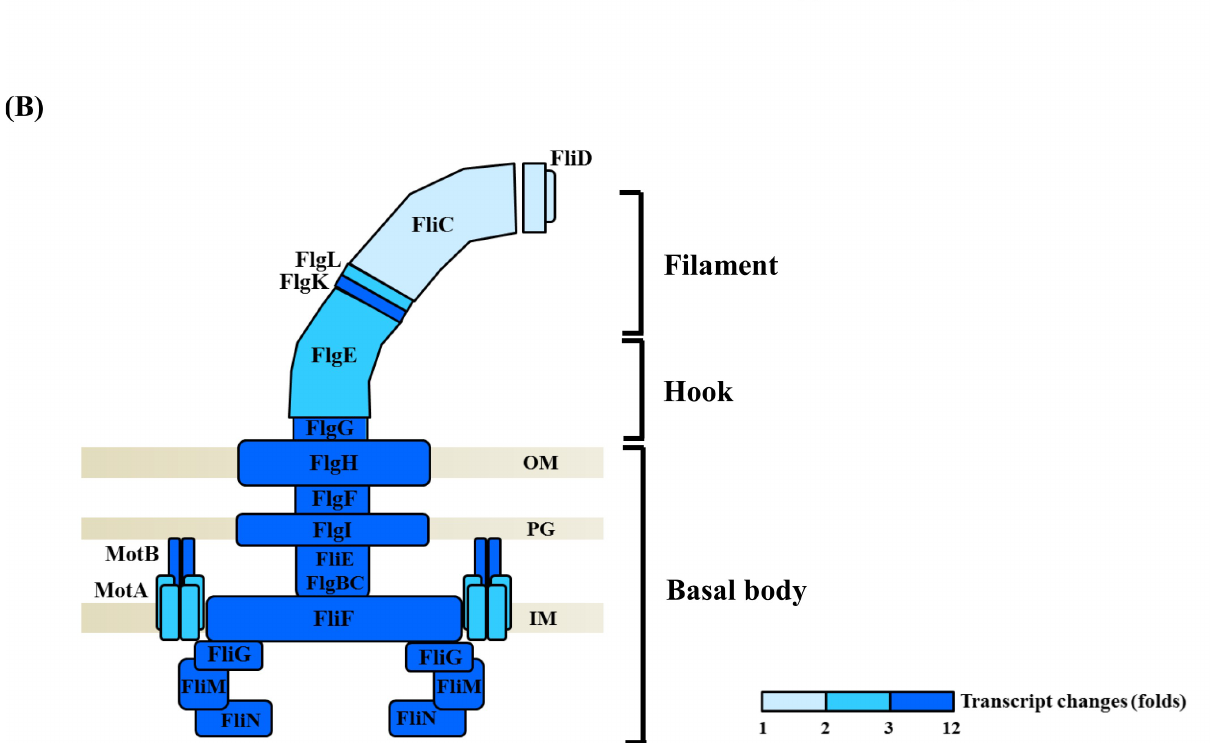
PLOS ONE | https://doi.org/10.1371/journal.pone.0174704 April 24,